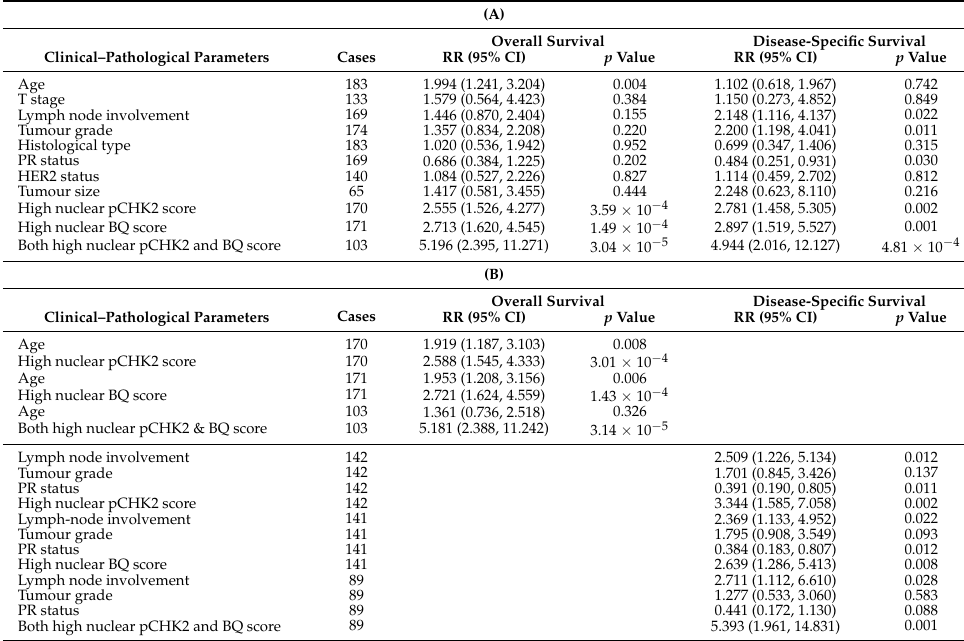
(A) OverallSurvival Disease-SpecificSurvival